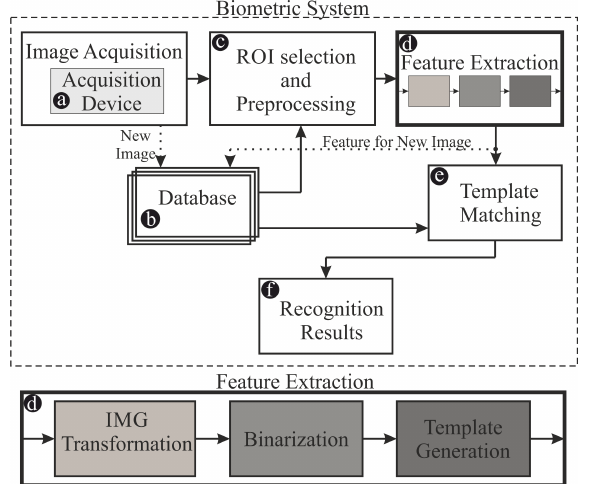
Figure 4. The overview of the biometric pipeline used in the experiments. The highlighted block— IMG Transformation —is the place where the new algorithm is